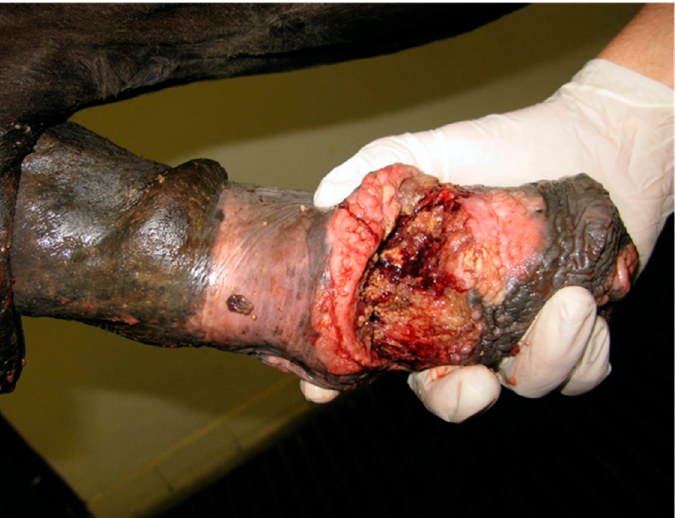
Figure 9. Appearance of the penile/preputial wound at the external physical examination (clinical case 4).